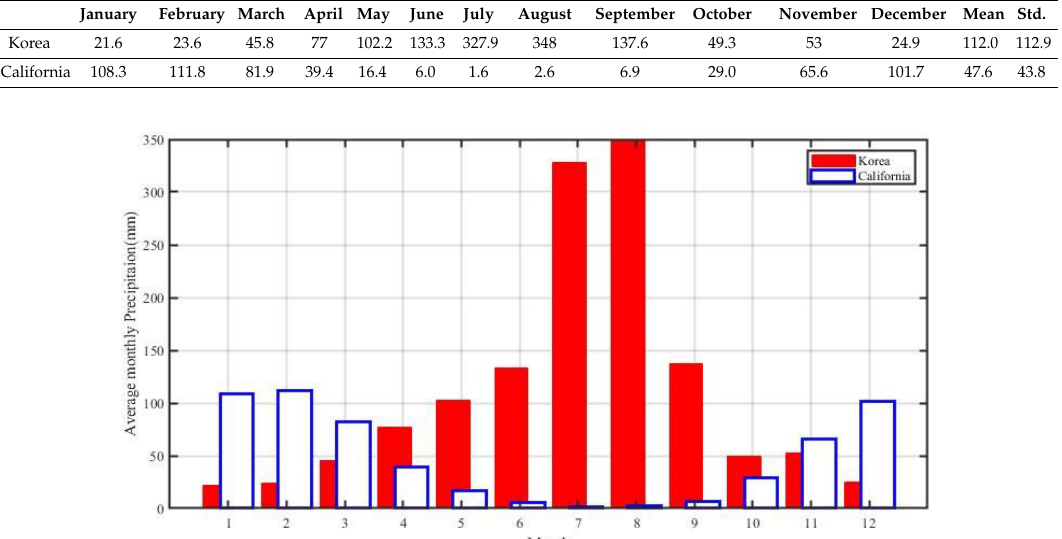
Table 4. Monthly mean precipitation in Korea and California (unit: mm ) [32].